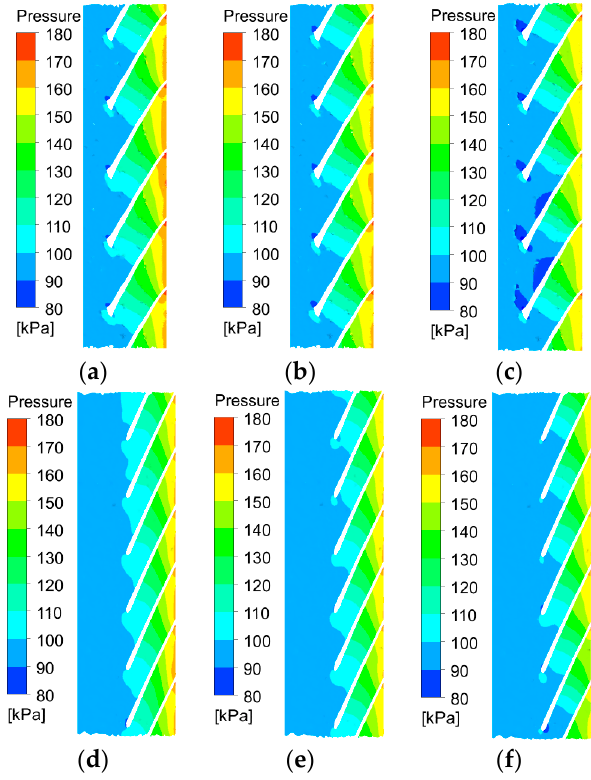
Figure 20. Pressure comparison at span = 90% under different working conditions: ( a ) Origin, 0.8 Q d ; ( b ) Origin,1.0 Q d ; ( c ) Origin, 1.25 Q d ; ( d ) Optimal, 0.8 Q d ; ( e ) Optimal, 1.0 Q d ; ( f ) Optimal, 1.25 Q d.